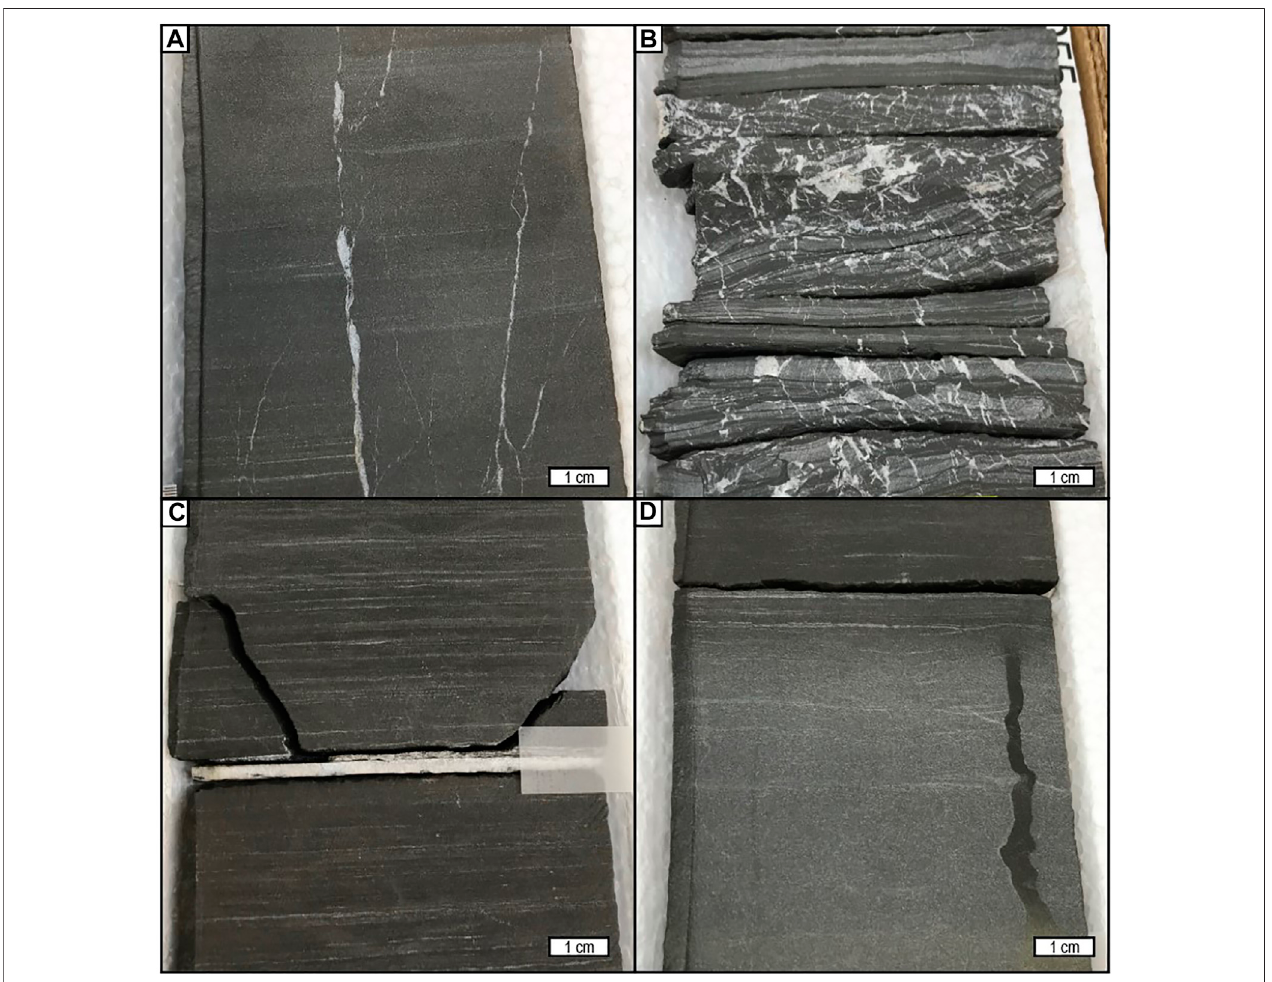
FIGURE 3 | Fracture types. (A) Vertical fractures. (B) Brecciated zone. (C) Bedding-plane parallel fracture. (D) sediment- fi lled fractures rich in organic matter.